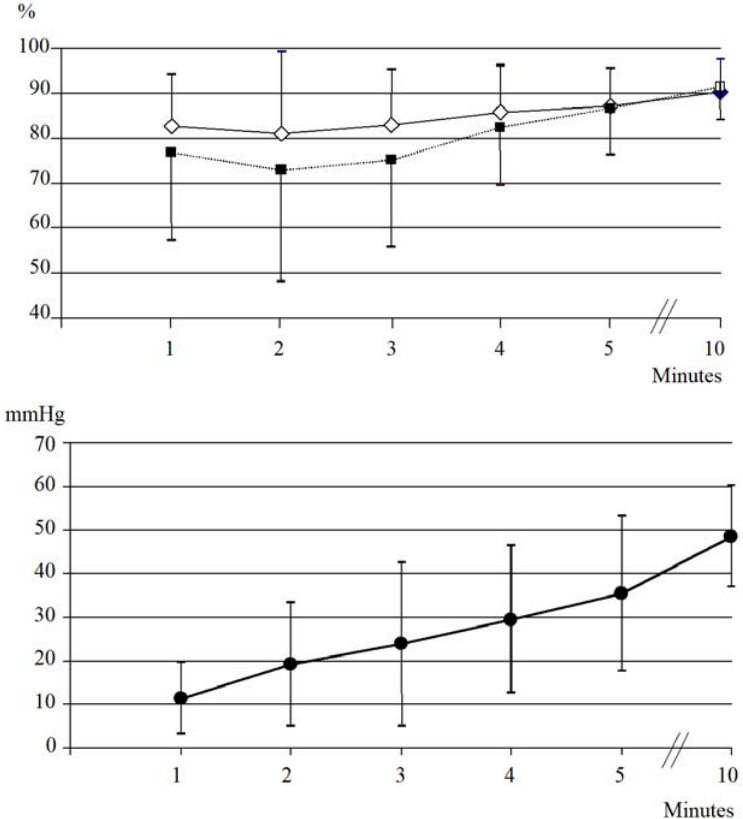
(white diamonds) and SpO 2MASIMO ; ( bottom ) during period 2TOSCA